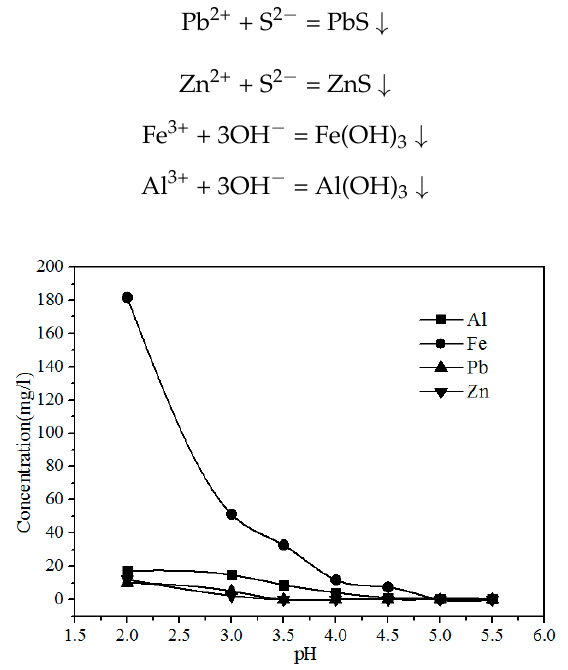
Figure 9. Effect of pH on the concentration of Al, Fe, Pb, and Fe in the leach solution.